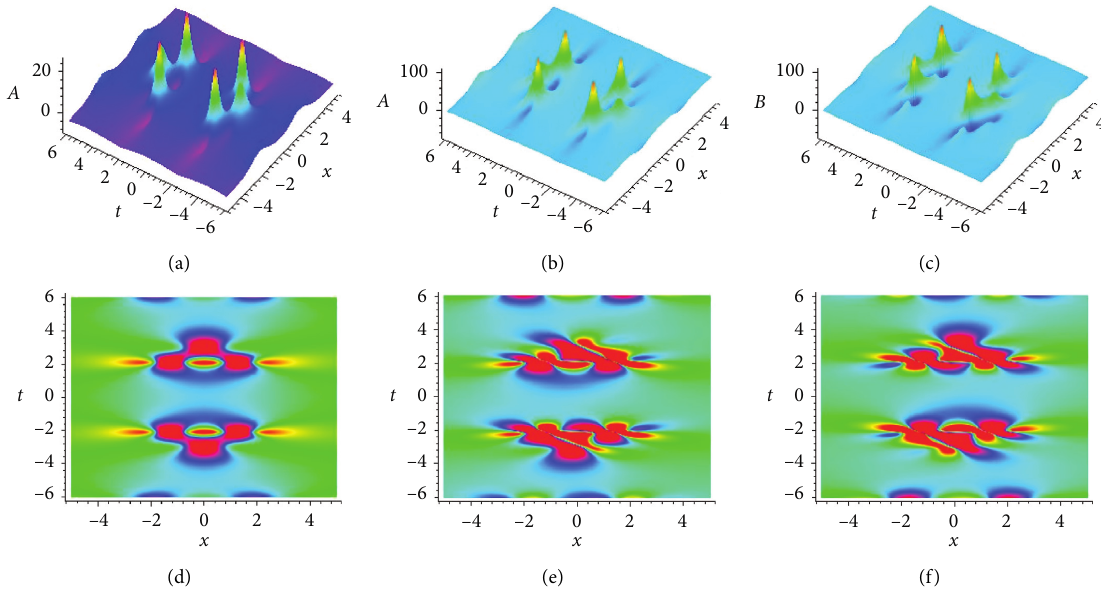
Figure 7: The second-order t -breather solution of equation (34) with (a) b density plots of (a)–(c), respectively.